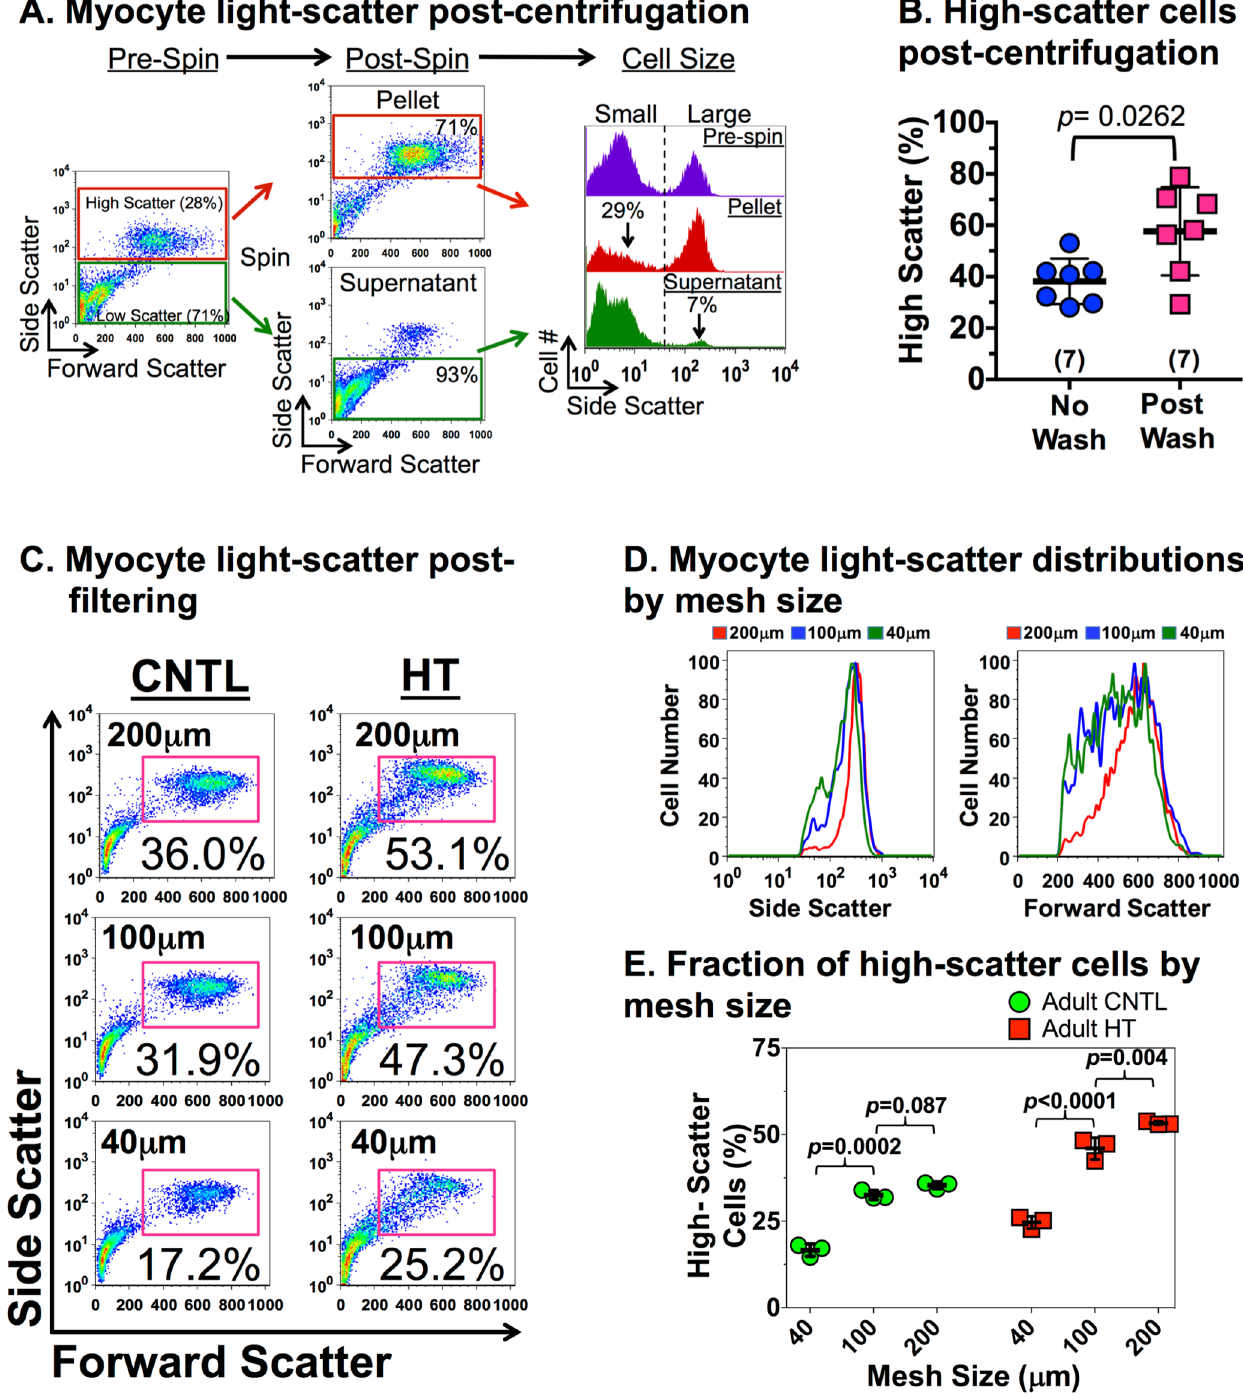
Fig 3. Variability in flow cytometric signatures. A, Ventricularcells were either not washed(pre-spin)or washedwith low-speed centrifugation (post-spin, 50xg for 1 min x2), fixed and analyzedby flow cytometry (FCM). Post-spin, the pelletretains larger cells (i.e. ventricular myocytes, VMs) and the supernatantretains smaller cells (i.e. nonmyocytes). CellularDNA is labeledwith propidiumiodideto gate on nucleated cells only. Bivariate plots show the forward and side-scatter signature of nucleatedventricular cells (4,000–7,000cells per run). High-scatter (red box) and low-scatter (green box) sub-populations represent the predominantly VM and nonmyocyte subpopulations respectively,and are gated accordingly. Pre-andpost-spinFCM show that the wash and spin loses large VM (~7%) to the supernatant and contaminates the pellet with small nonmyocytes (~29%). B , The fraction of high scatter cells were quantitatedfrom multiple rabbits as shown in panel A without a wash or